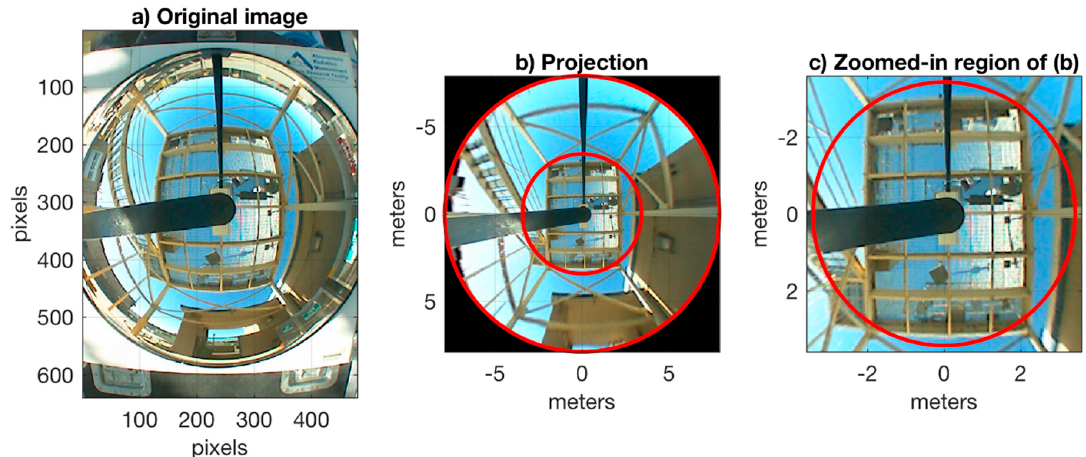
Figure 2. The calibration rig and calibration images to validate planar projection of TSI images. ( a ) the original TSI calibration image. ( b ) the TSI image projected to planar coordinates using the line-of-sight distance from the camera to the bottom of the support beams (2.9 m) as the cloud base height (CBH). Red circles show 50° and 70° zenith angles for reference. ( c ) Same as center but zoomed in to show the calibration rig. Blue dots at the corners of the rig were selected manually to determine projected platform size. The true platform size was 4.267 × 6.096 m and the projected platform size was 4.015 × 5.974 m, indicating a 3% error.